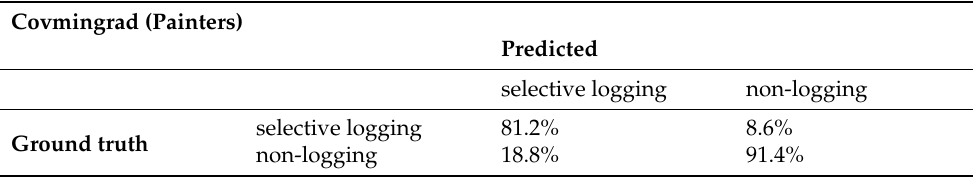
The Brazilian government, through the Brazilian Forest Service, has developed a system, called DETEX [62], for mapping selective logging. Figure 6 shows the polygons of areas affected by illegal logging in the year 2018. In the same figure, it is possible to observe that detections through CNNs (in magenta) have the advantage of delimiting the scar in the canopy of each tree or set of removed trees, while DETEX (in yellow) presents only a polygon delimiting the affected area.